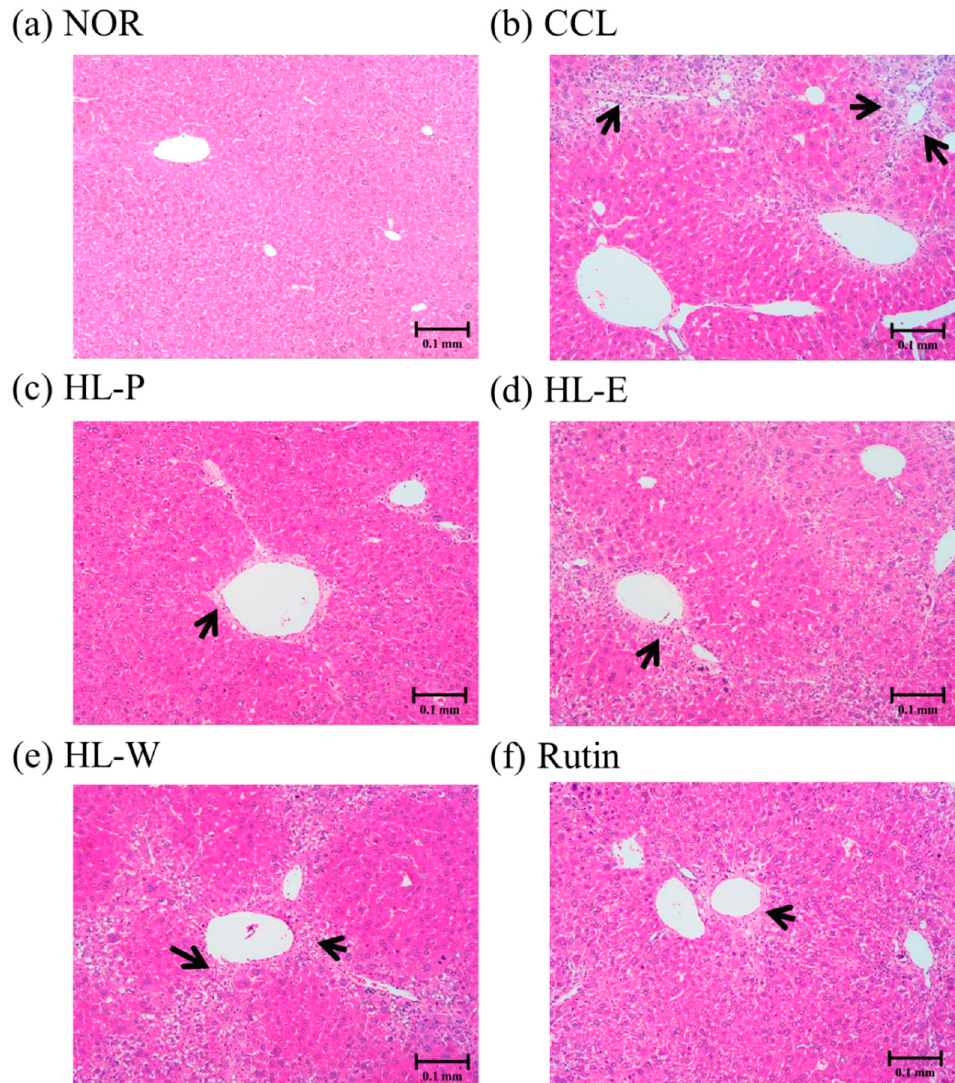
Figure 3. The effects of red quinoa and its extracts on hepatic pathological changes of CCl 4 -induced liver injury mice. Magnification 100× (black arrows indicate the position of liver injury). ( a ) NOR: normal group. ( b ) CCL: CCl 4 -induced liver injury mice. ( c ) HL-P: CCl 4 -induced liver injury mice fed 5.13 g/kg (rutin 8.46 mg/kg) of red quinoa-powder. ( d ) HL-E: CCl 4 -induced liver injury mice fed 1.54 g/kg (rutin 16.4 mg/kg) of red quinoa-ethanol extracts. ( e ) HL-W: CCl 4 -induced liver injury mice fed 1.54 g/kg (rutin 3.92 mg/kg) of red quinoa-water extracts. ( f ) Rutin: CCl 4 -induced liver injury mice fed 16.4 mg/kg of rutin.